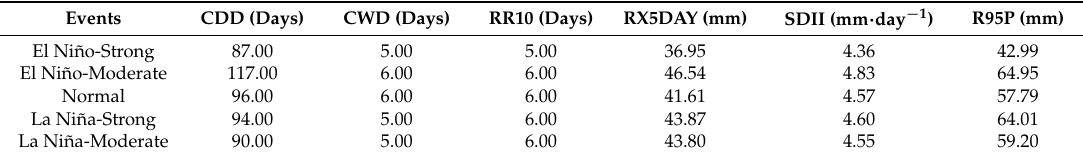
Table 7. Average values of extreme precipitation indices in different El Niño–Southern Oscillation (ENSO) years and normal